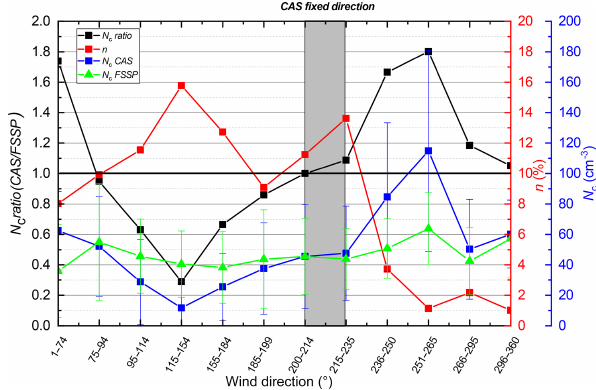
Figure 7. Number concentration ratio ( N cratio ) , number of obser- vations ( n ), and N c of the CAS probe and the FSSP for each part of the 360 ◦ wind rose as it was divided for detailed investigation. The gray rectangle corresponds to wind iso-axial